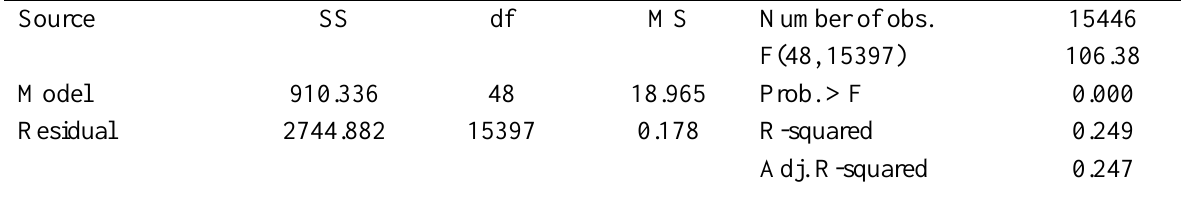
Table 4. The impact of independent variables in access to credit on process